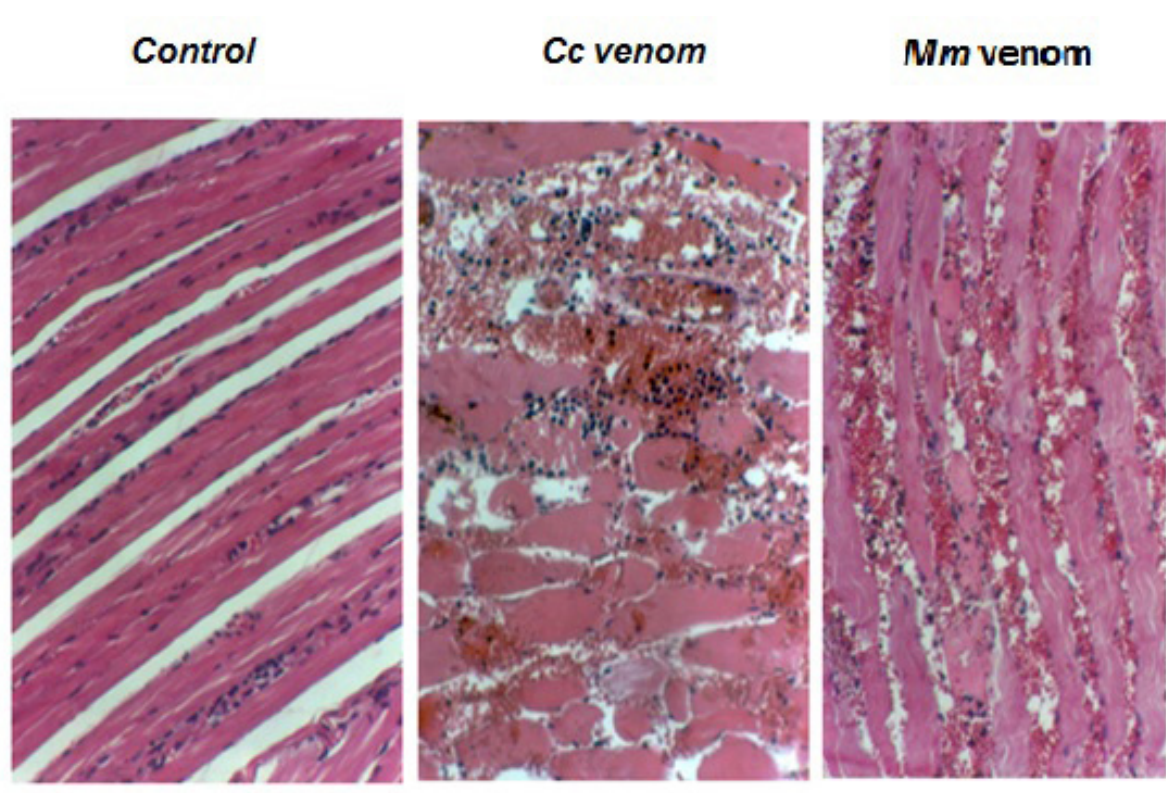
Figure 4. Effect of sublethal dose of Cerastes cerastes ( Cc ) and Macrovipera mauretanica ( Mm) venoms (7 μg of each venom/20 g mice) on the muscular